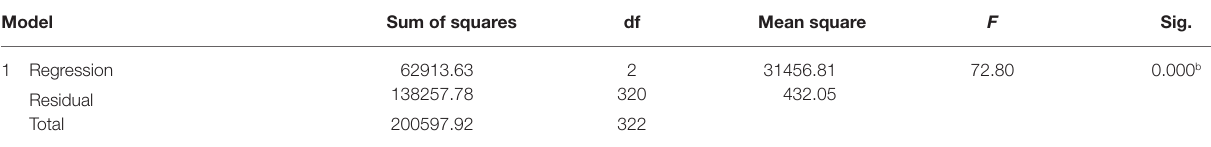
TABLE 6 | ANOVA for the relationship among teachers’ resilience, emotion regulation, and success. Model Sum of squares df Mean square